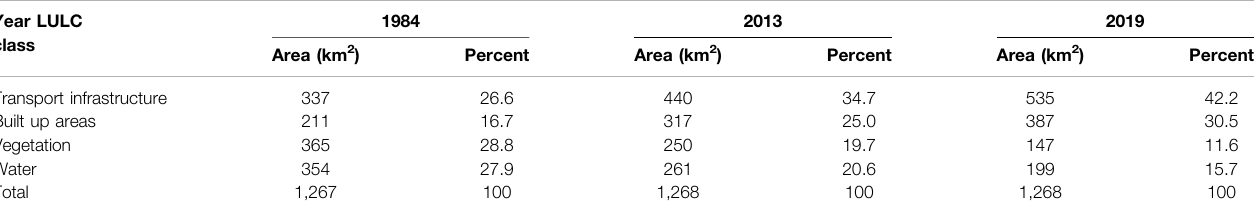
TABLE 2 | Statistics of LULC areas in Lagos from 1984 to